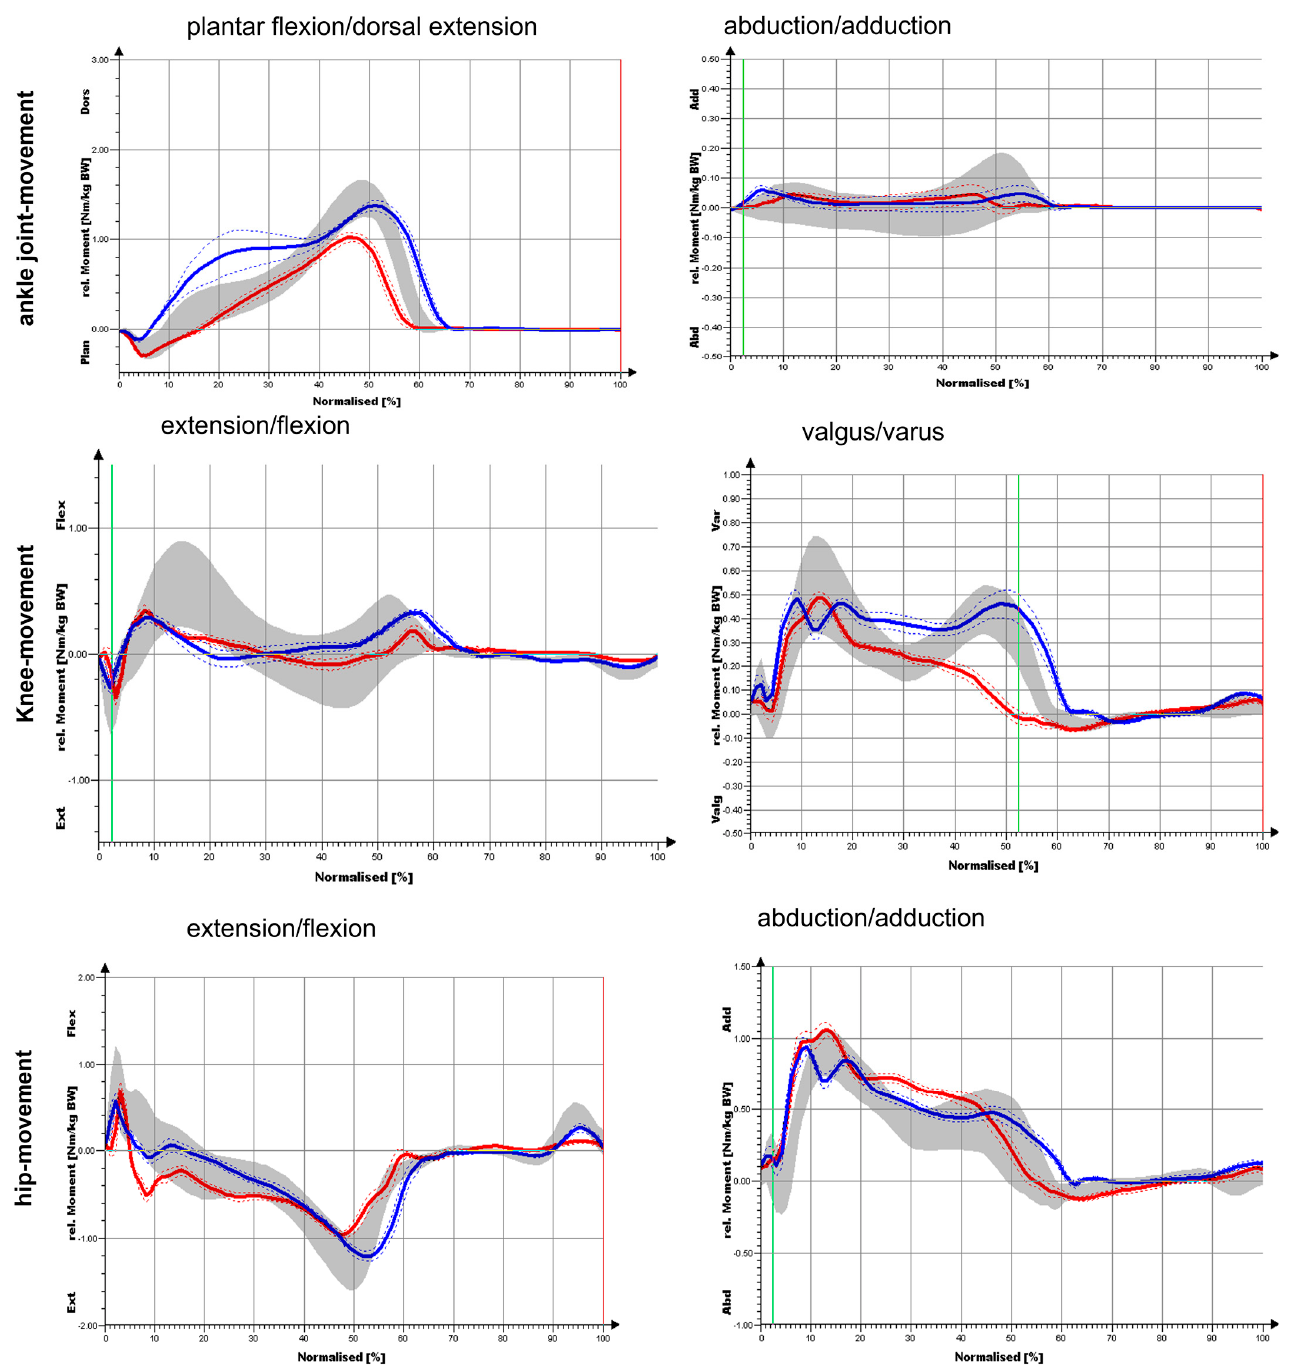
Figure 3. Joint moment progression of the ankle joint, knee and hip during a complete gait cycle in the sagittal plane (flexion/extension) and frontal plane (abduction/adduction).